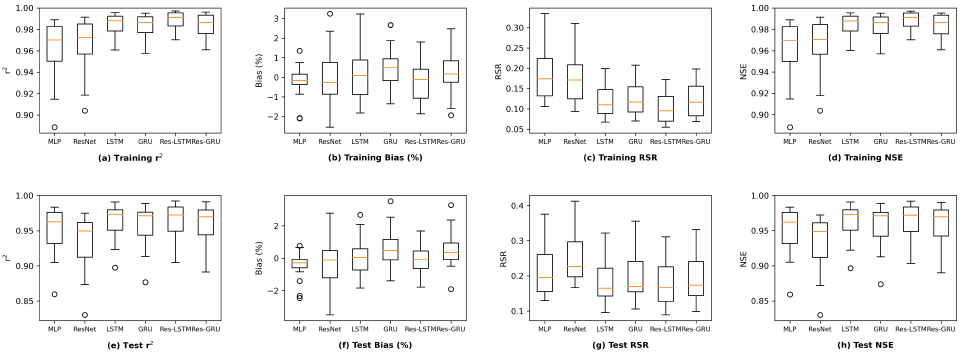
Figure 10. Comparison of six models on observed data at hourly time step with daily